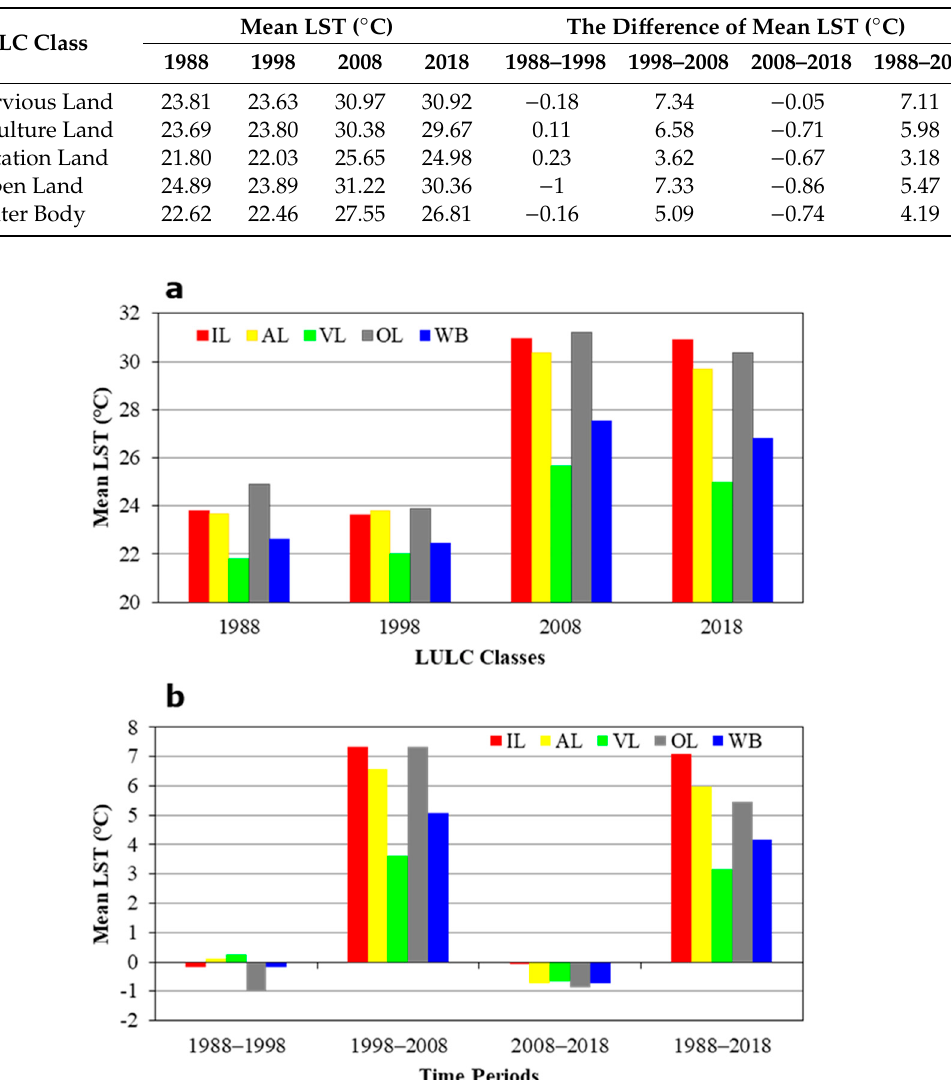
Figure 5. Spatial distribution of mean LST (°C) for different LULC classes at all time-points, ( a ) mean LST; ( b ) difference in mean LST.